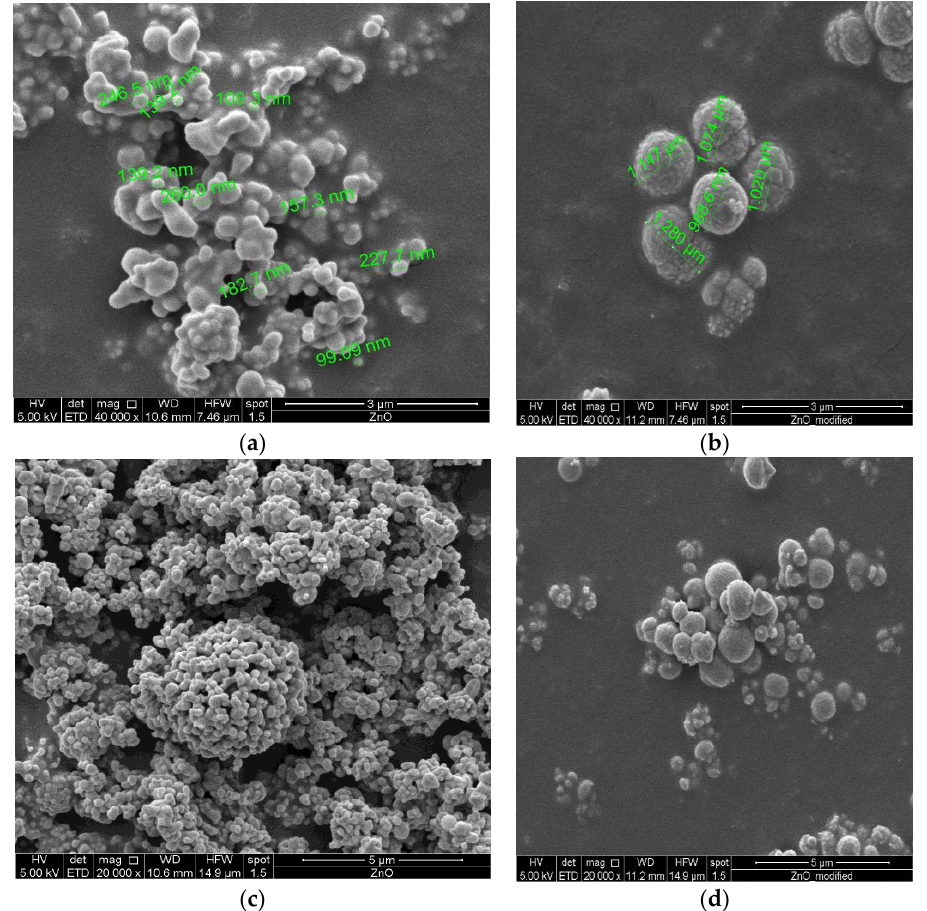
Figure 4. SEM micrographs of ( a , c ) ZnO and ( b , d ) ZnOc powders. (a,b) 40000×; (c,d) 20000×.